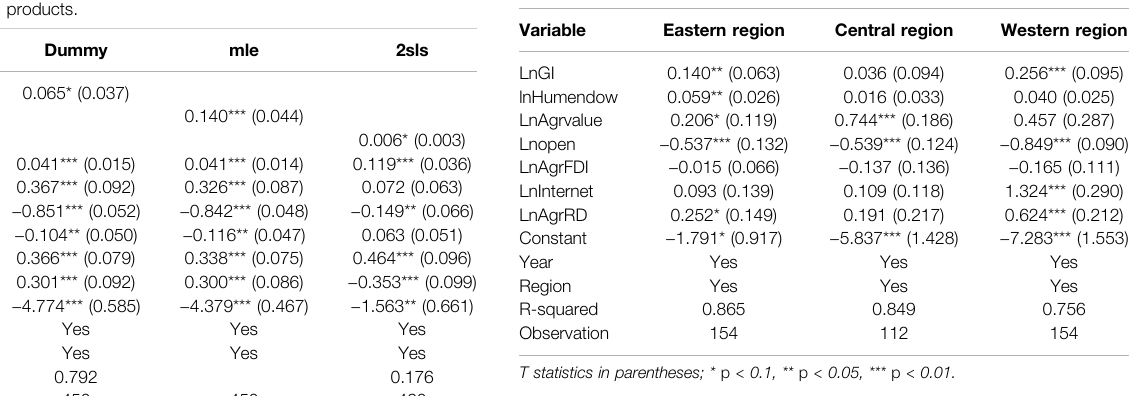
TABLE 5 | Heterogeneity analysis based on different